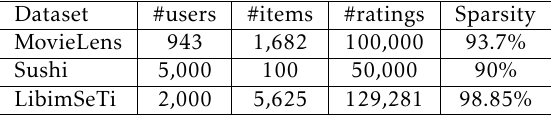
Table 1. Statistics of the